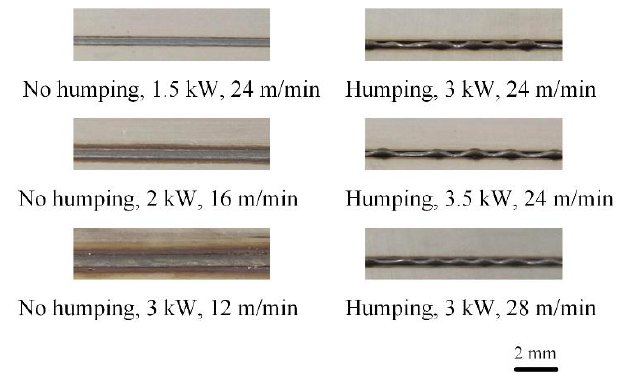
Figure 9. Weld appearance under different welding parameters.